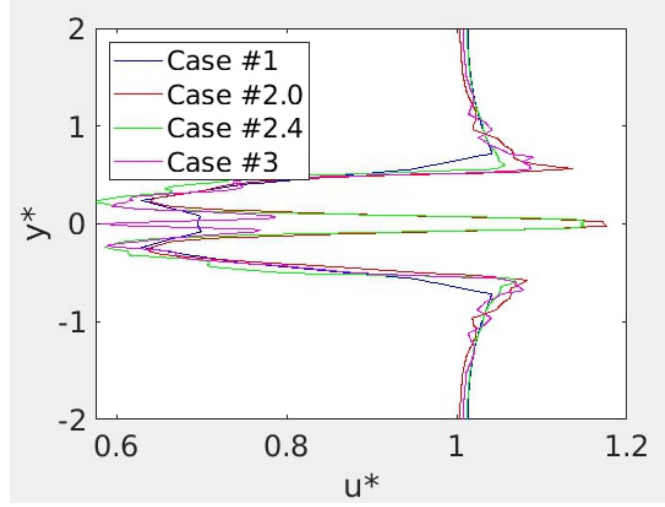
Figure 13. u ∗ magnitude along y ∗ for #1, #2.0, #2.4 and #3 at x ∗ = 1.2.